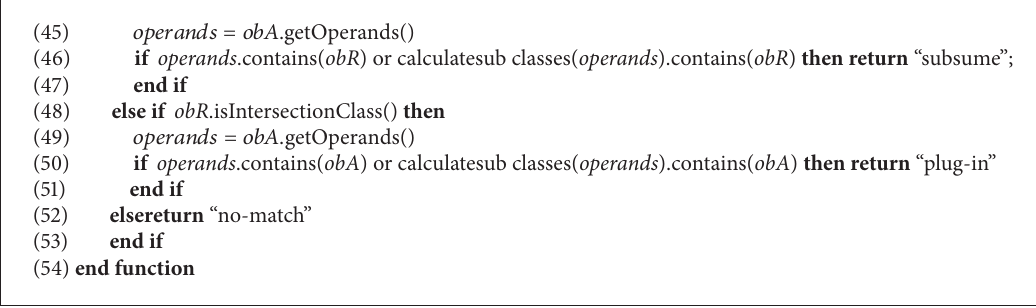
Algorithm 1: Pseudo code of our UnionIntersectionMatch algorithm.